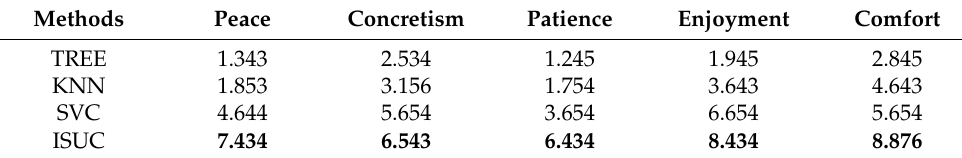
Table 1. Shows the experimental outcomes for positive